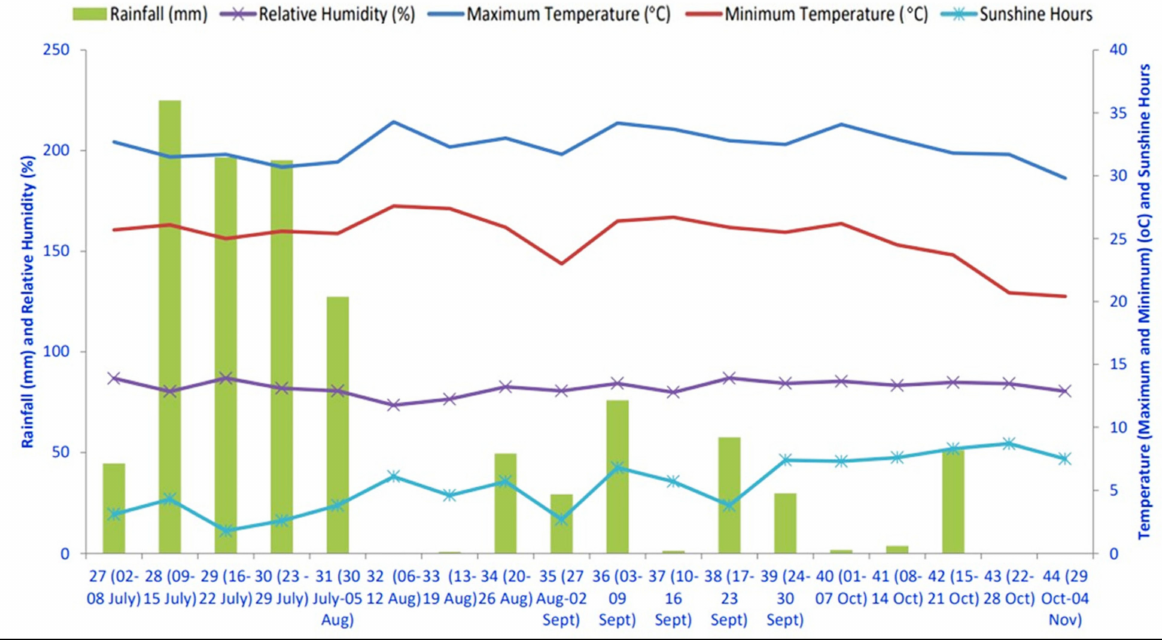
Figure 2. Weather parameter during the experimental period during 2015.